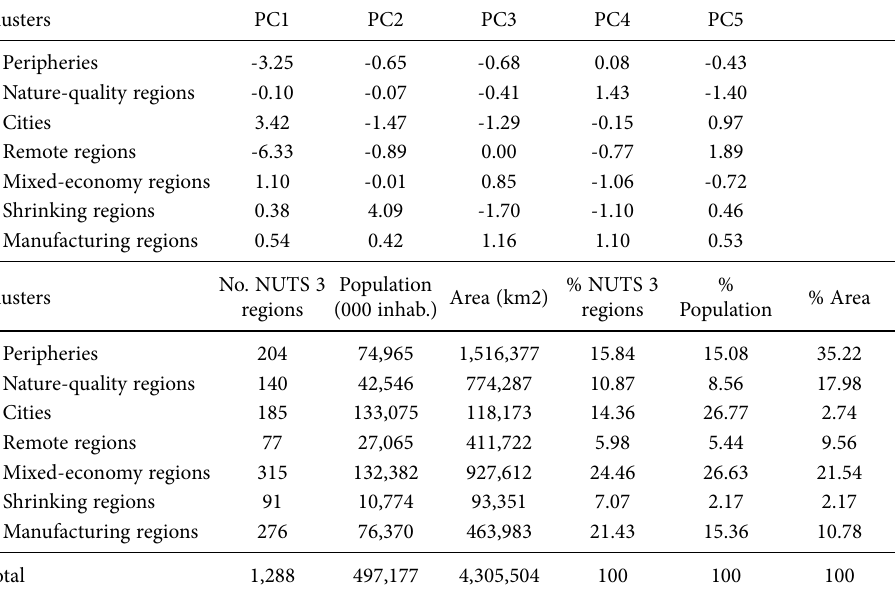
Table 3. Defining typologies: cluster centres according to the 5 PCs and size in terms of number of regions, population, total